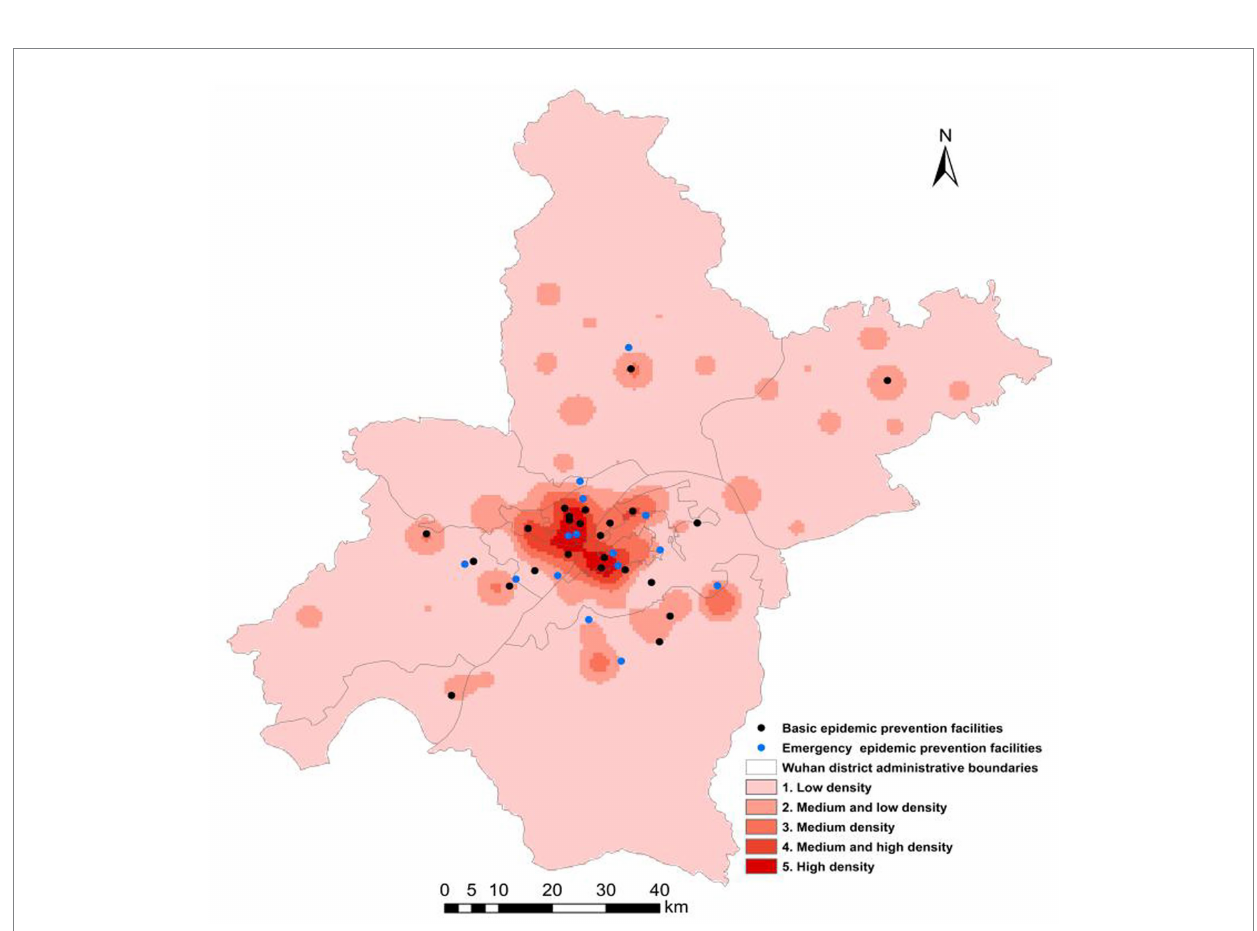
FIGURE 2 Spatial distribution of epidemic disaster prevention facilities and population density in